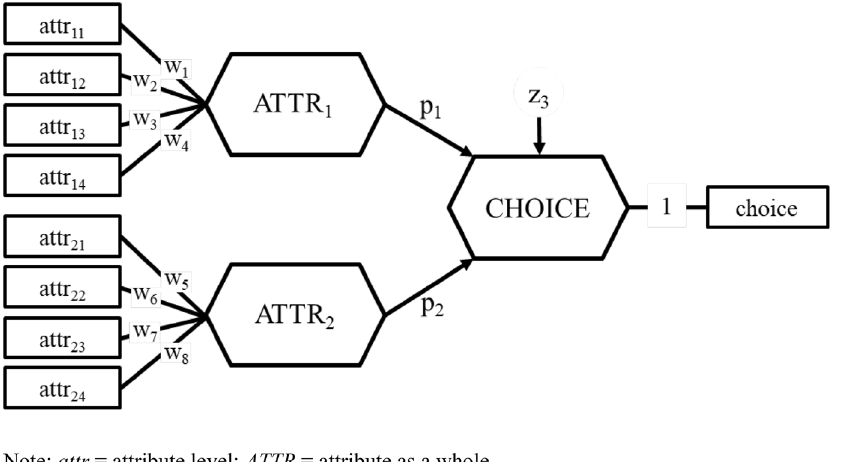
Fig. 2 PLS path model using DCE